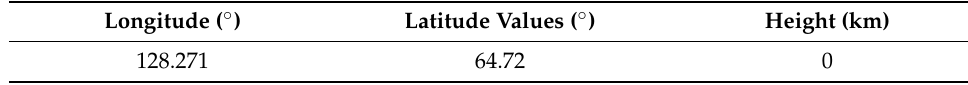
Table 1. Ground target location.